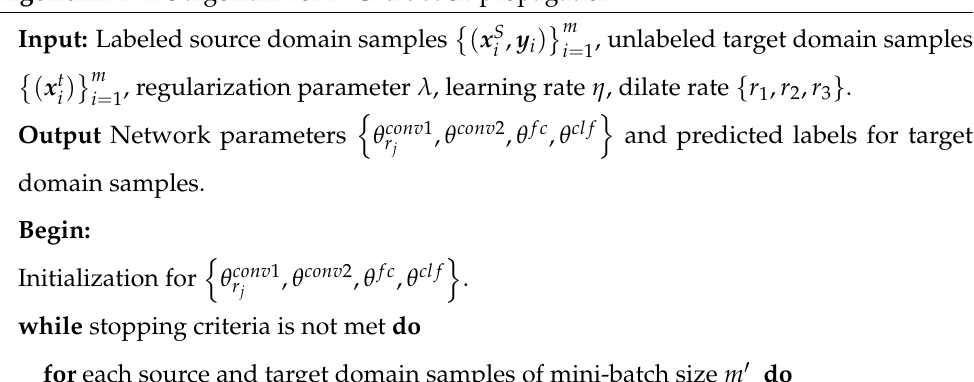
Algorithm 1 The algorithm of FFCNN